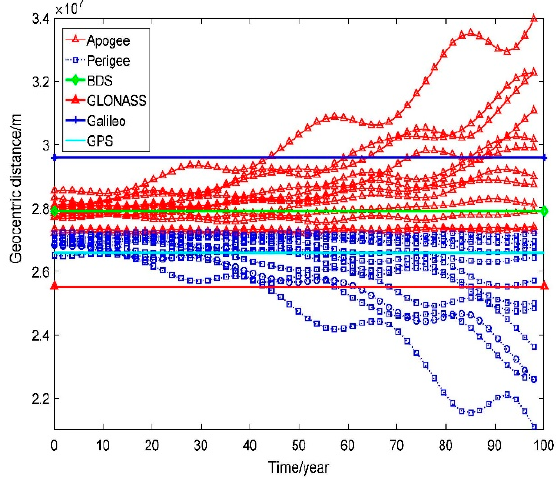
Figure 9. Orbital variations of GPS spent upper stages over 100 years.